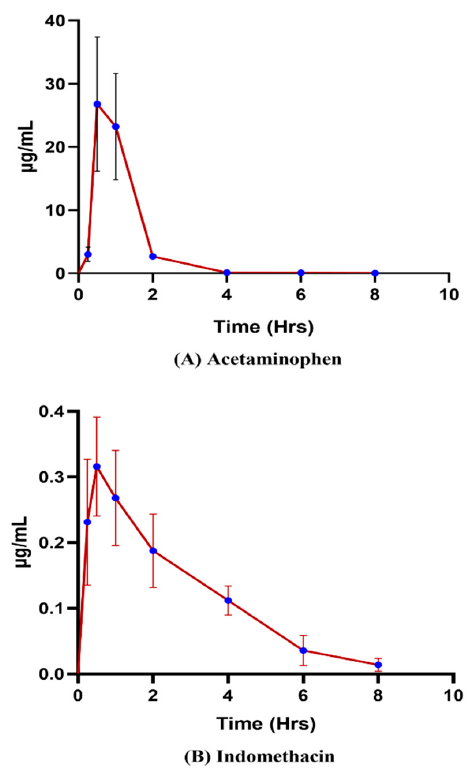
Figure 8. ( I ) Selected ion chromatograms of ( A ) solvent blank ( B ) plasma blank ( C ) LLOQ (1 ng/mL) ( D ) LQC (3 ng/mL) ( E ) MQC (300 ng/mL) ( F ) HQC (600 ng/mL) of acetaminophen (206 min) and ( G )